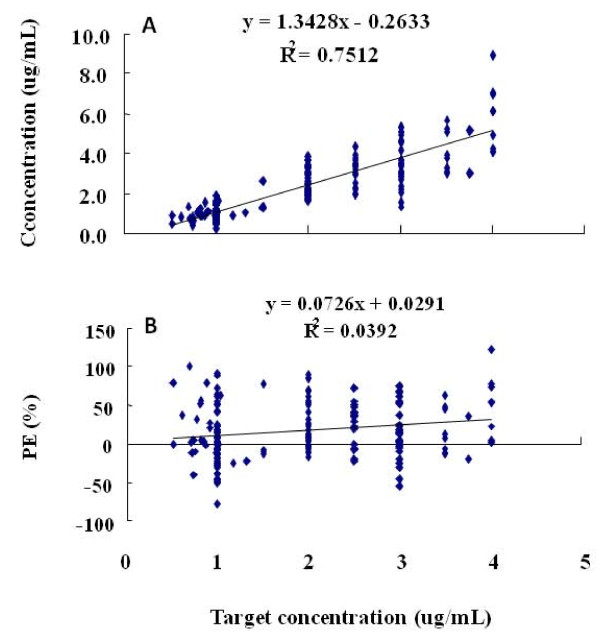
Predicted concentrations of Propofol in 1<year< 8 by SLOG TCI-III (Pediatric) system (Figure 1A), and performance error (PE%) against the calculated concentrations in 1<year< 8 by SLOG TCI-III (Pediatric) system (Figure 1B).